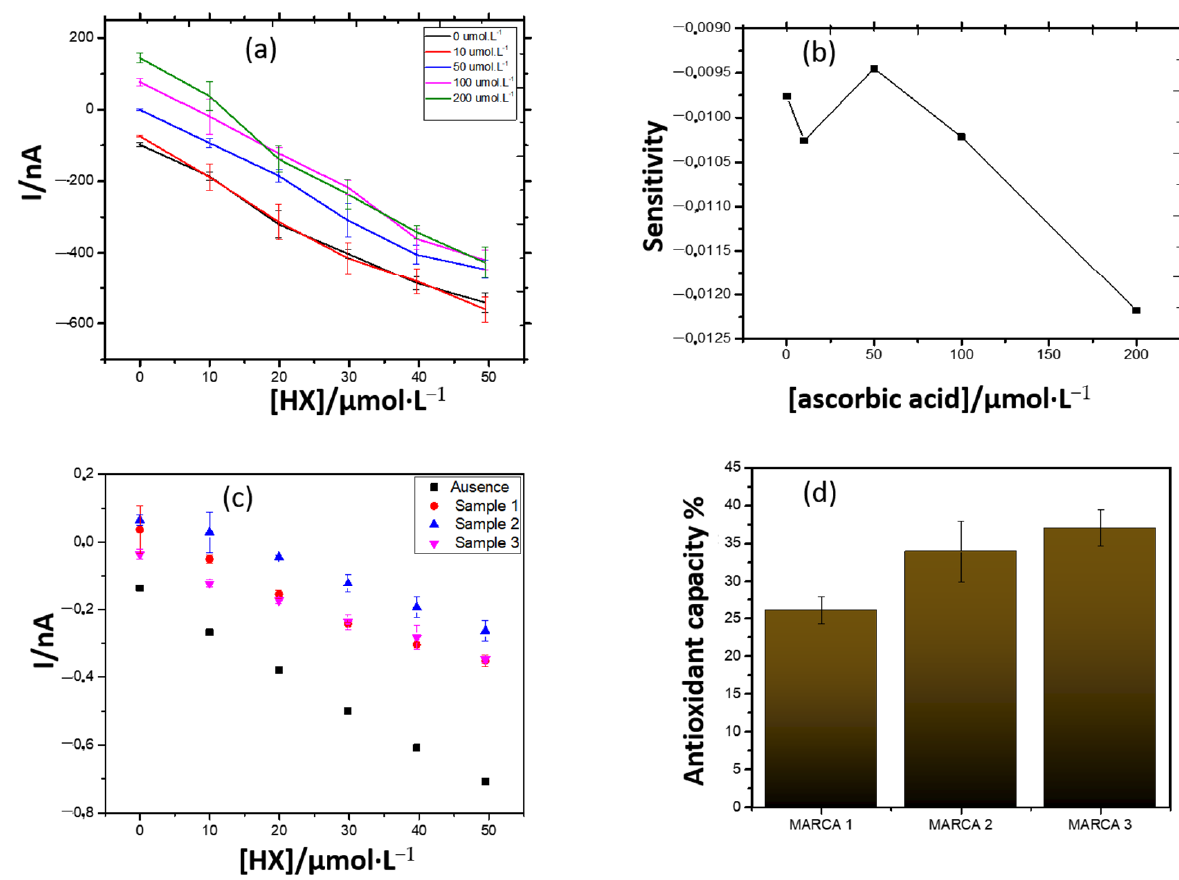
Figure 7. ( a ) Evaluation of the antioxidant capacity of ascorbic acid (standard) using the amperometric biosensor. ( b ) Sensitivity curve, in terms of the slopes of the curves showed in ( a ). ( c ) Response of the biosensor in the presence of the antioxidant samples. ( d ) Antioxidant capacity of drugs containing ascorbic acid against the biosensor.